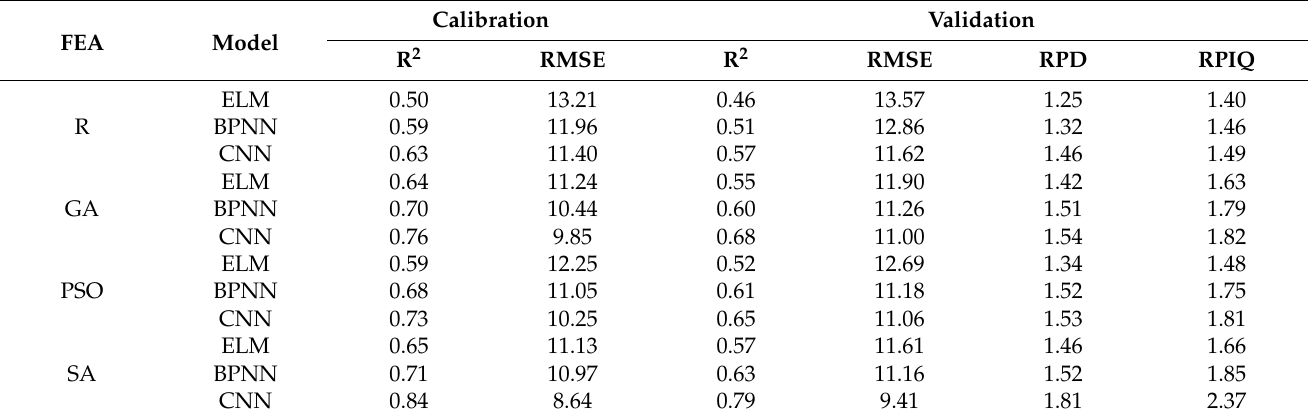
Table 3. Comparison of prediction accuracy of different SS models (g kg − 1 ).